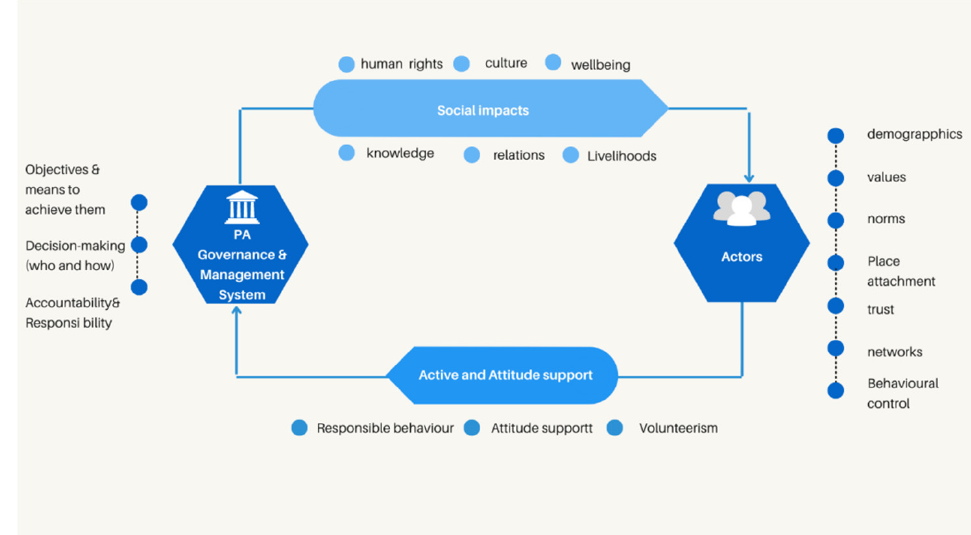
Figure 1. Exploring public support for protected areas.